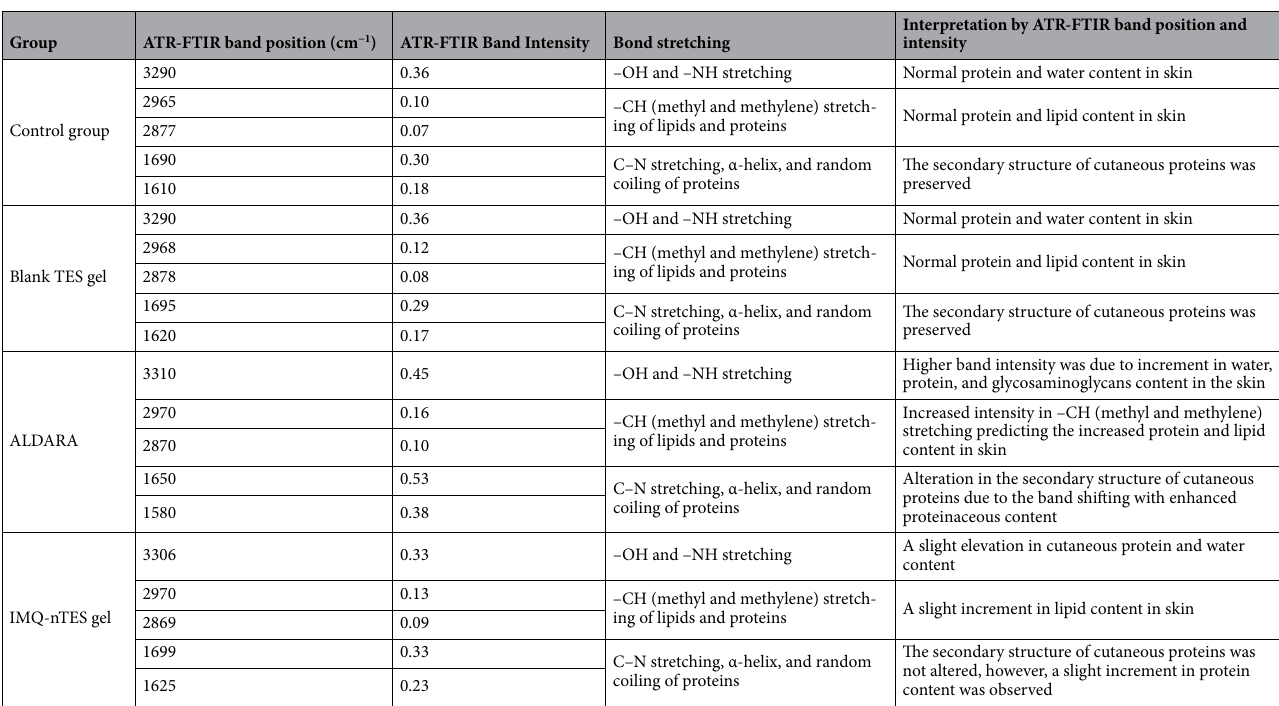
Table 7. ATR-FTIR skin analysis for determination of skin structure